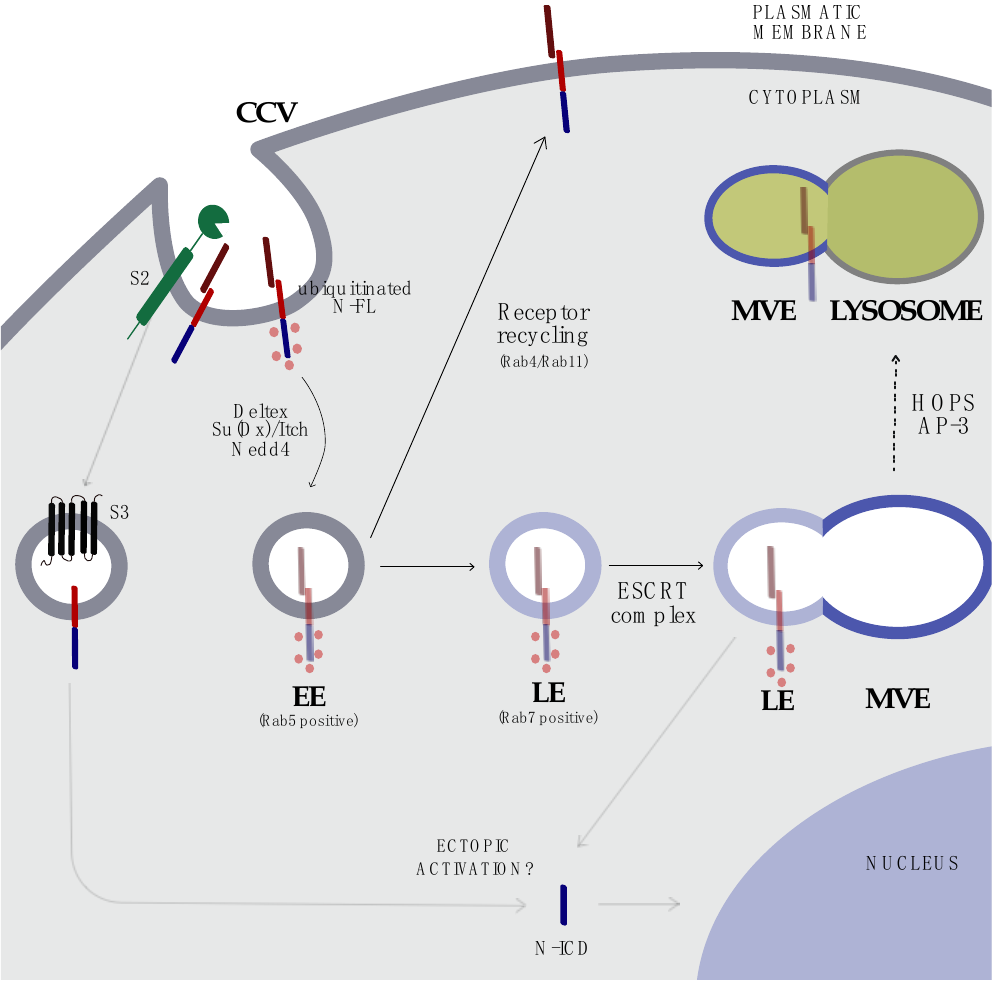
Figure 2. Overview of NOTCH endocytosis and vesicular trafficking. NOTCH proteins are monoubiquitinated by Deltex, Su(Dx)/Itch, Nedd4, and E3 ligase and endocytosed in clathrin-coated vesicles (CCV), resulting in Rab5-positive early endosomes (EEs). EEs might follow two different routes: (i) recycling back to the membrane through a Rab4/Rab11-positive endosome compartment and (ii) sorting into a Rab7-positive late endosome (LE), followed by ESCRT complex-mediated fusion into multivesicular endosome (MVE). The role of γ-secretase in EE and the release of N-ICD is less clear. From MVE, NOTCH proteins can be ectopically activated or MVE can fuse with the adaptors HOPS and AP-3 and, finally, with lysosomes, enabling NOTCH degradation. CCV: clathrin-coated vesicles; EE: early endosome; LE: late endosome; MVE: multi-vesicular endosome; N-FL: NOTCH full length; N-ICD: NOTCH intracellular domain.